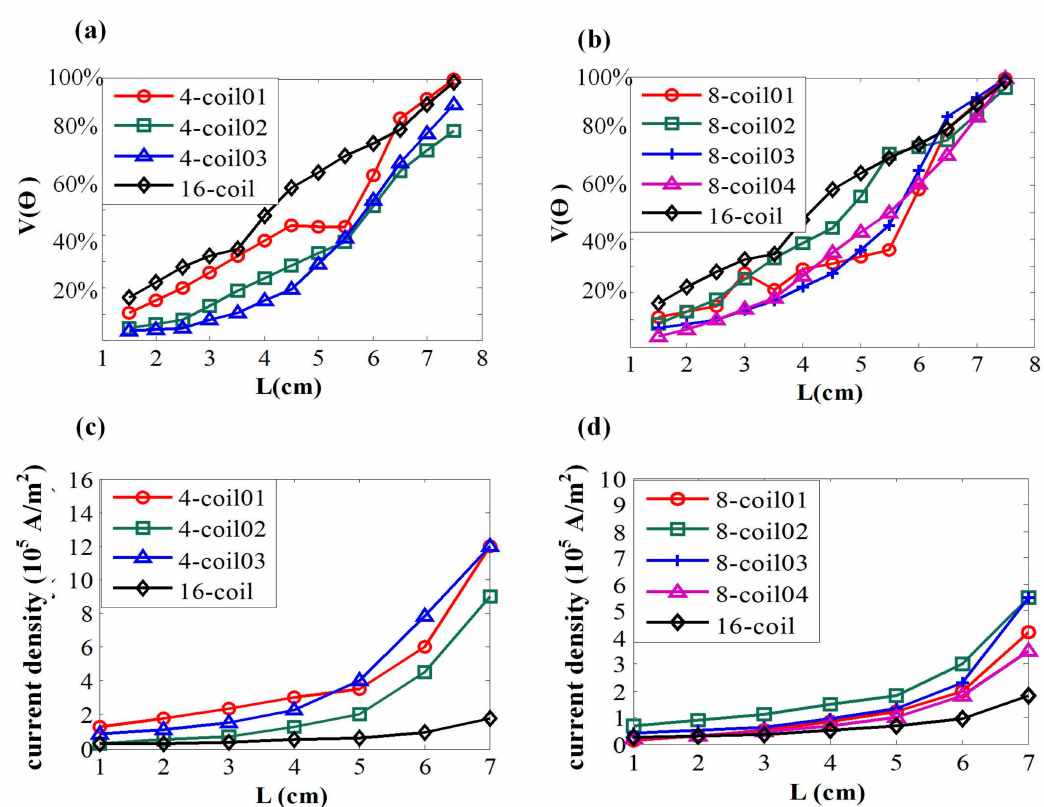
Figure 7. ( a ) Overall activated proportions targeting at different stimulated depths. L indicates the length from superficial layer to the interested depth of brain tissue. ( b ) The relationship between targeted depths and activated proportions. ( c , d ) Variation tendency of current density with the increase of targeted depth. The input energy is represented by current density of each individual